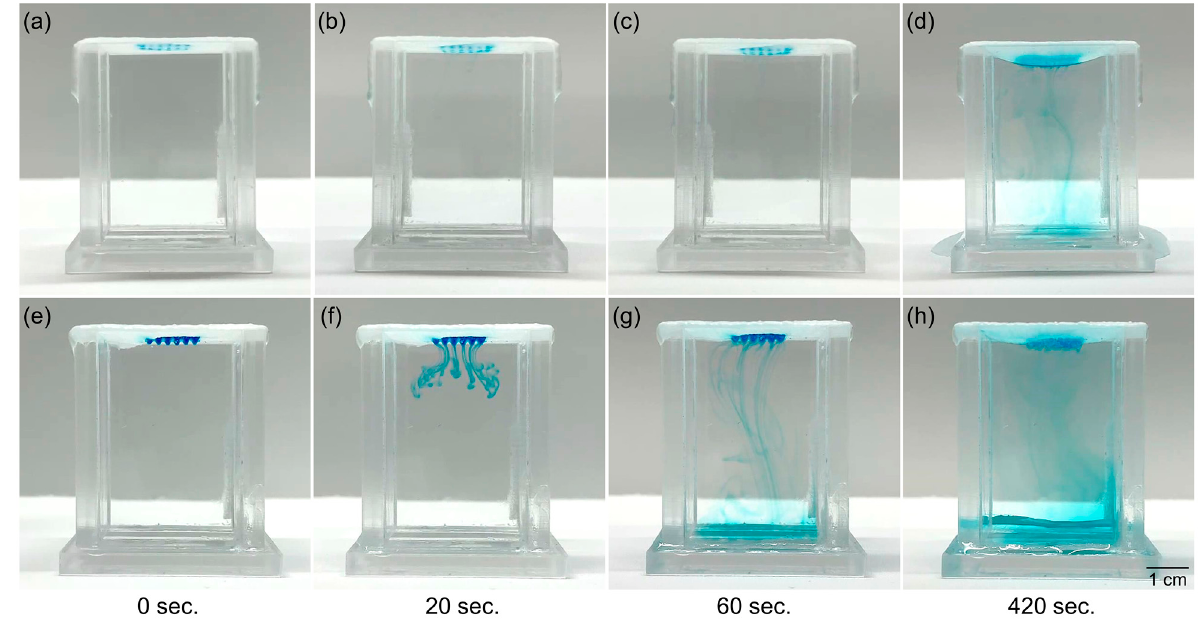
Figure 6. The role of electrospun bilayer membranes for diffusion profiles as a substrate at different wettability values. ( a – d ) The tracked images of HA hydrogel array mixed with watercolor ink (blue) toward the upside and ( e – h ) in the opposite direction.